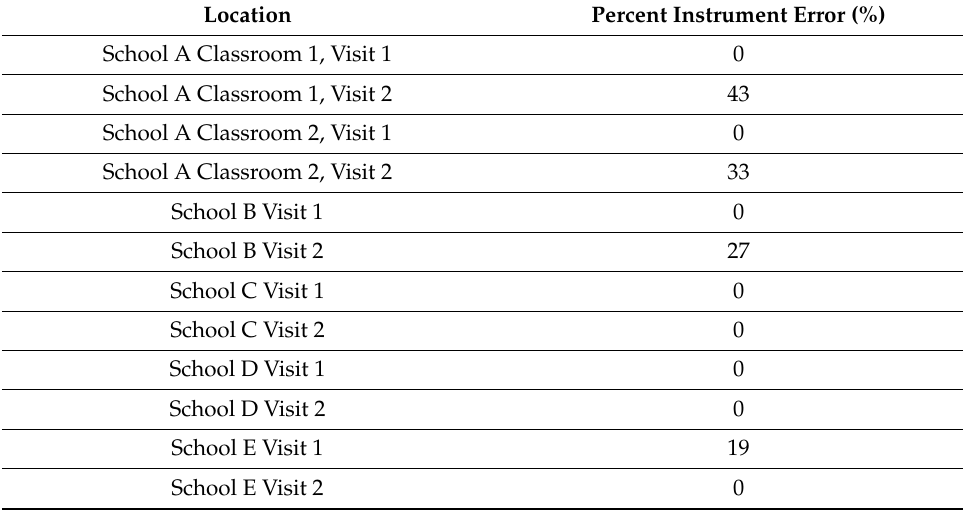
Table 4. Percentage of missing or error flagged data.